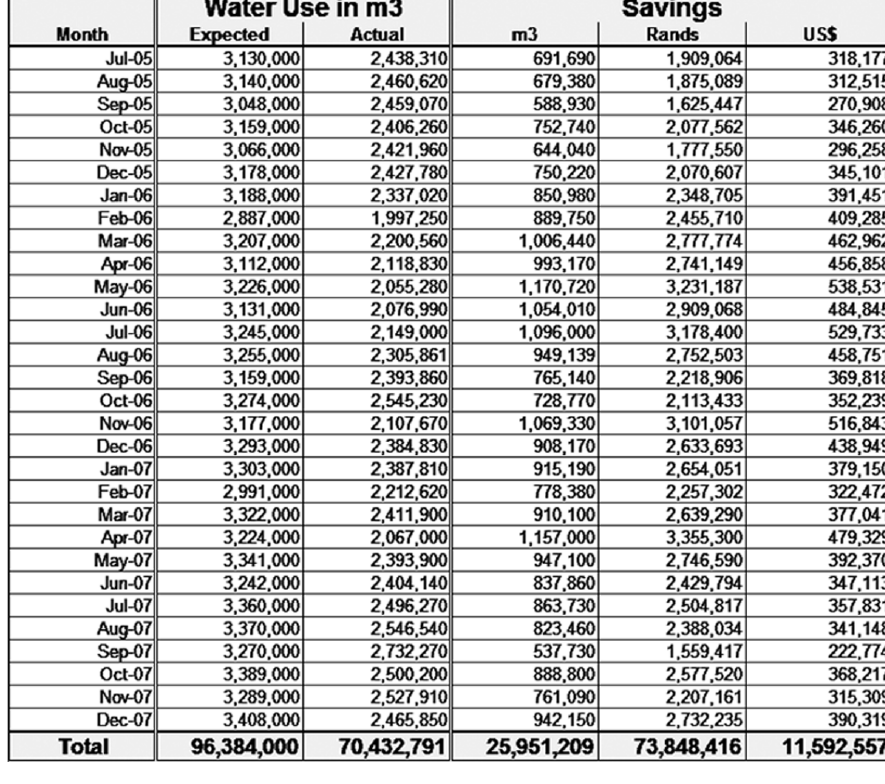
Summary of water and financial savings for first 30 months of